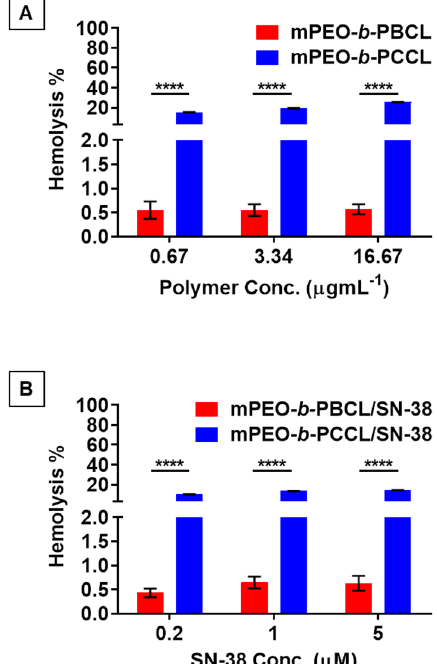
Figure 7. Hemolytic activity of ( A ) mPEO- b -PBCL and mPEO- b -PCCL, ( B ) mPEO- b -PBCL / SN-38 and mPEO- b -PCCL / SN-38 micellar formulations against rat red blood cells (RBCs). Each error bar represents the mean ± SD ( n = 3). The concentrations of the polymers in the micellar formulations (0.67, 3.34, and 16.67 µ g · mL − 1 ) were equivalent to their respective concentration in the SN-38-conjugated formulations. SN-38 concentration of 0.2 (5 times less than IC 50 ), 1 ( ≈ IC 50 ), and 5 µ M (five times higher than IC 50 ) and their equivalent polymer concentrations were chosen for the study. Isotonic PBS and full hemolysis by pure water were used as negative and positive controls, respectively. All marked points were compared and were statistically significant if **** p ≤ 0.0001.